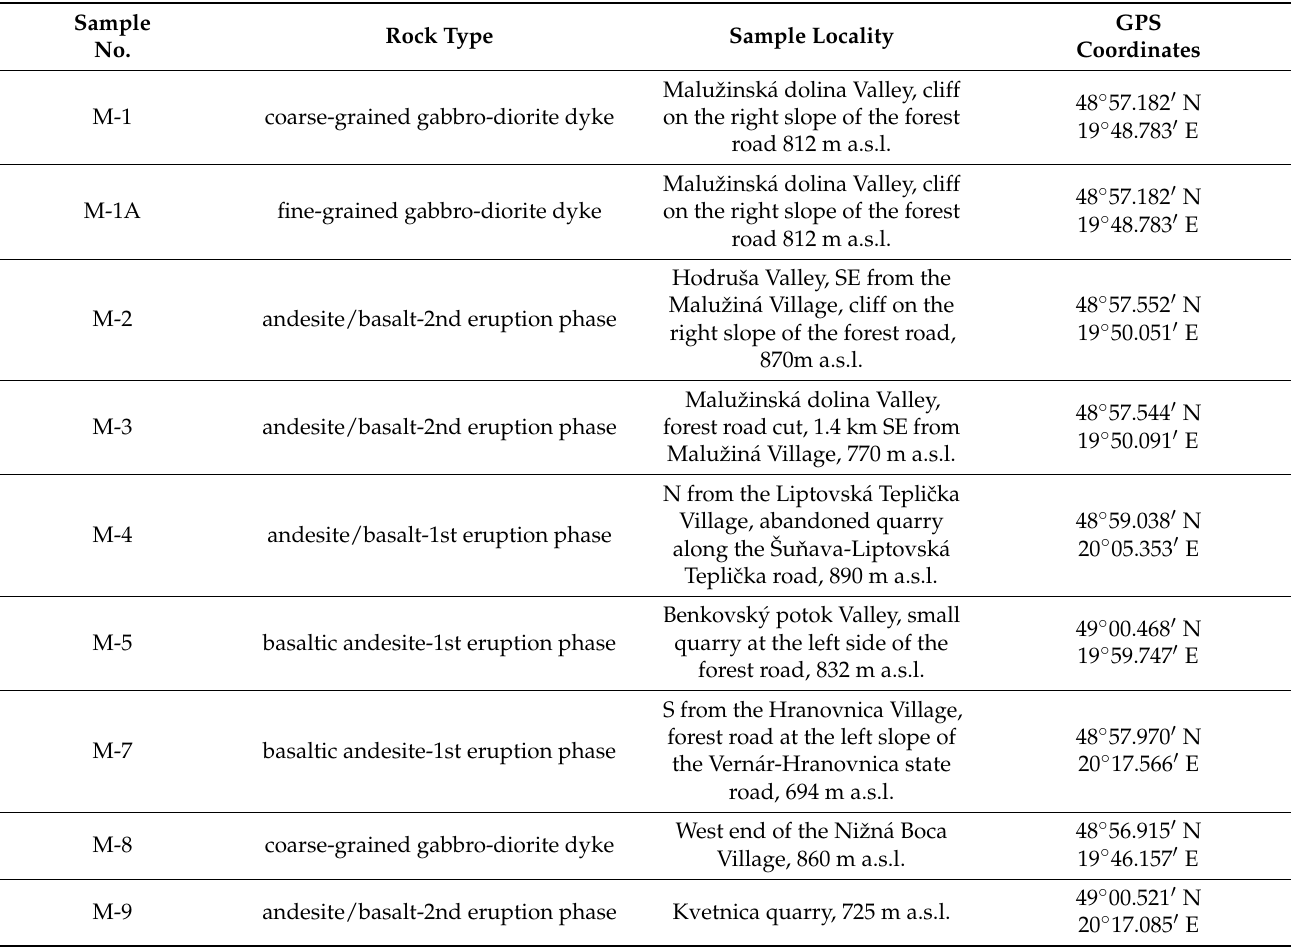
Table 1. Location of